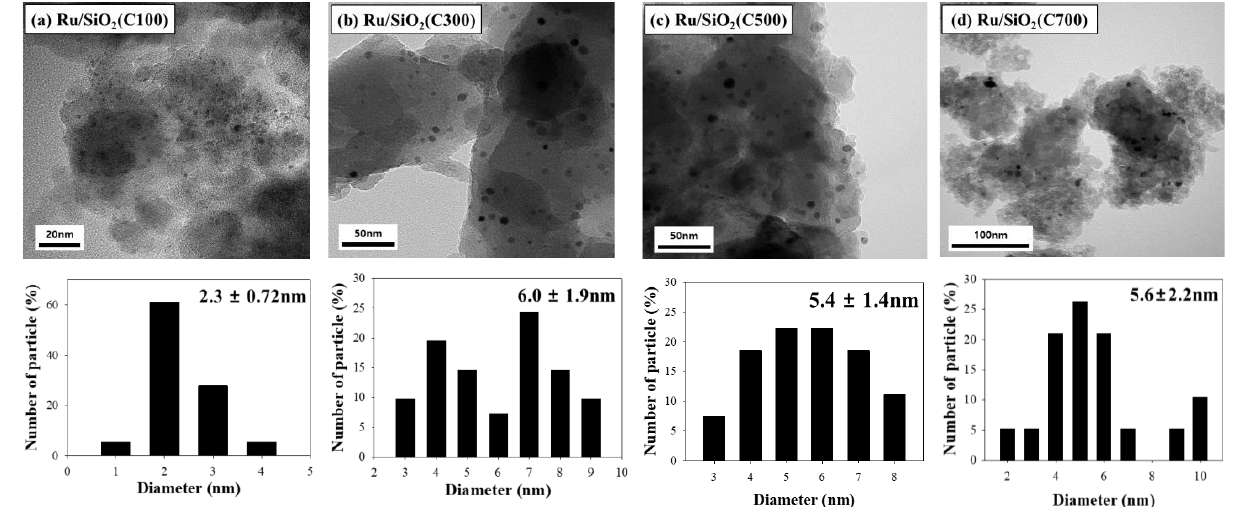
Figure 1. TEM images and particle size distributions of Ru metal for ( a ) Ru/SiO 2 (C100), ( b ) Ru/SiO 2 (C300), ( c ) Ru/SiO 2 (C500), and ( d ) Ru/SiO 2 (C700). All catalysts were calcined in air at different temperatures and subsequently reduced in H 2 at 350 ◦